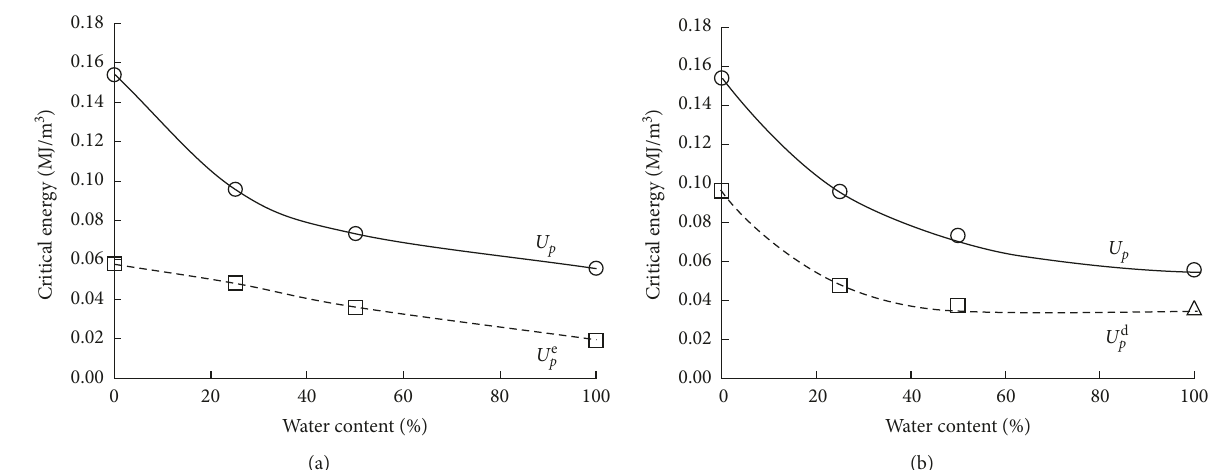
Figure 4: Characteristic curves of the critical energy. (a) U